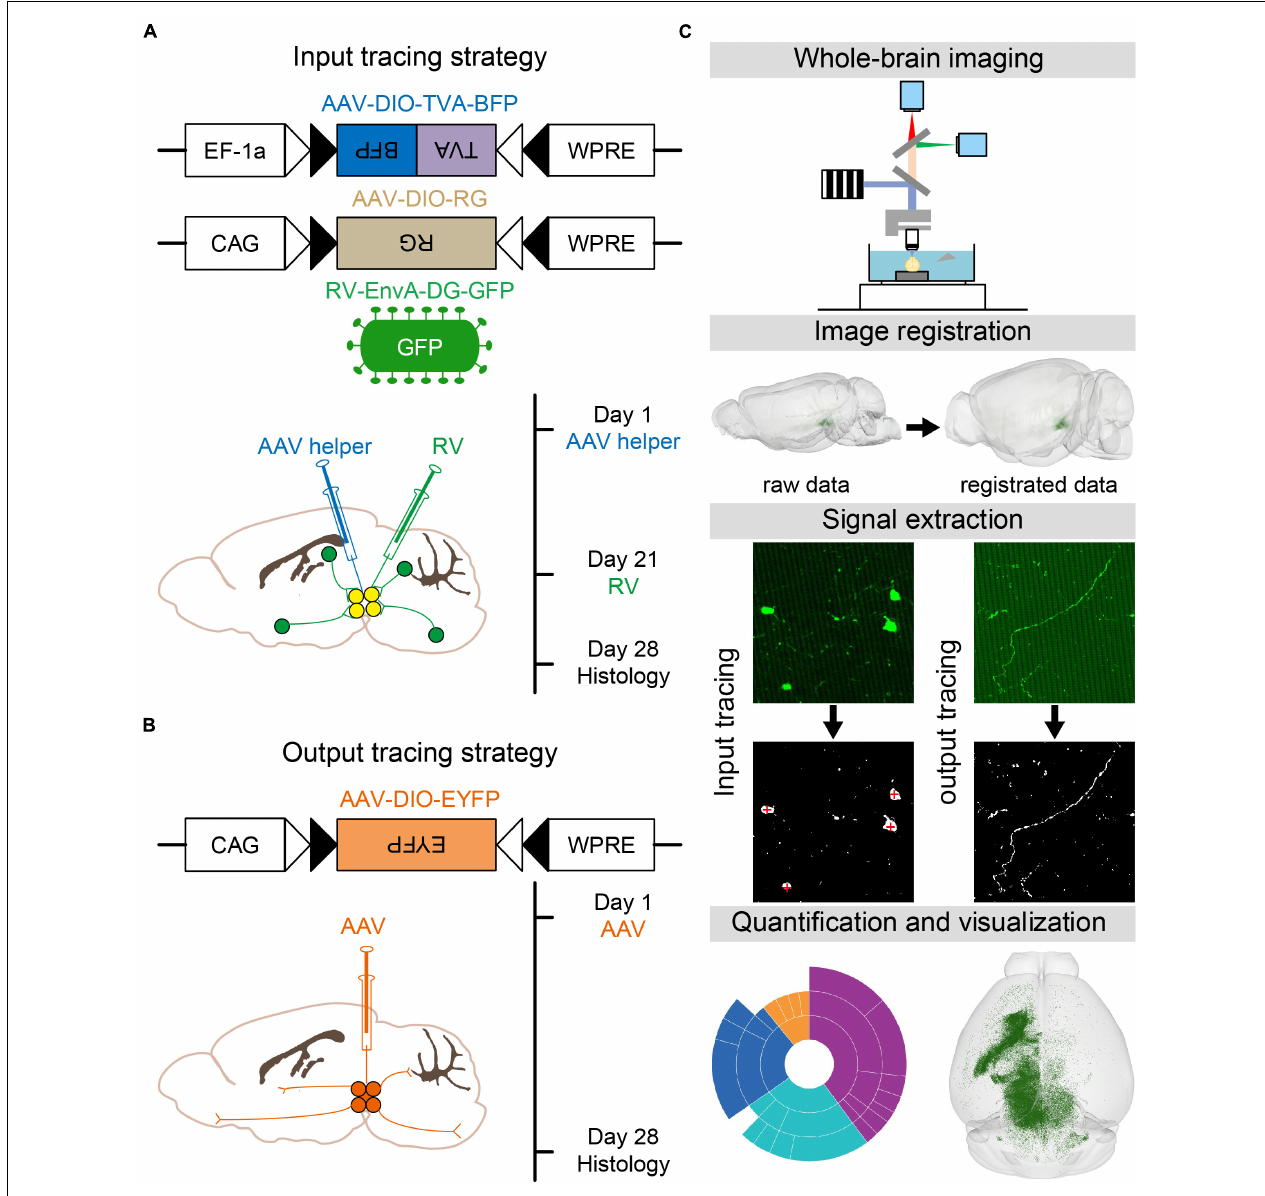
FIGURE 1 | Identification of whole-brain inputs and outputs of glutamatergic and GABAergic neurons in VTA and SNc. (A) Design of viral vectors and injection procedure for RV-mediated transsynaptic retrograde tracing. (B) Design of viral vector and injection procedure for tracing VTA and SNc output projections. (C) Main steps for data generation and